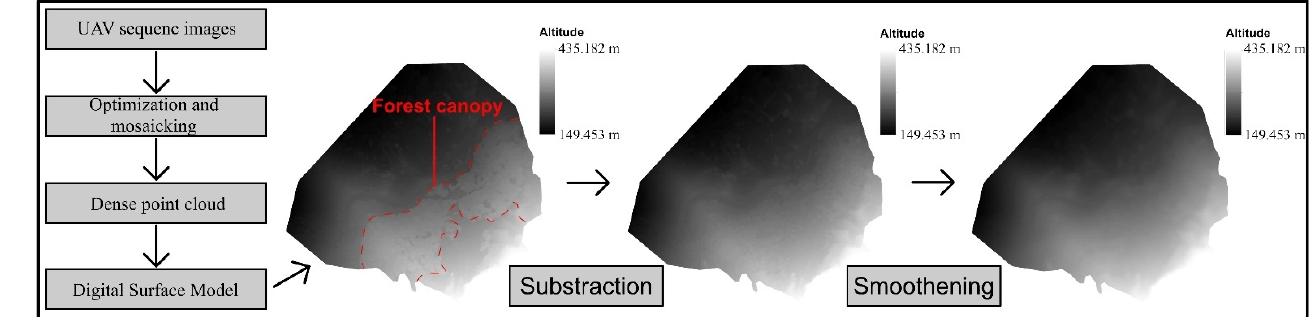
Figure 2. Processing chain of the UAV images.